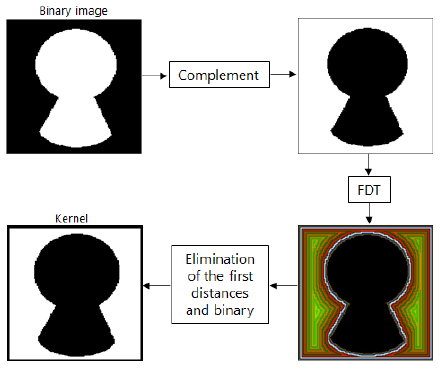
Figure 17. Operations to build binary kernels.